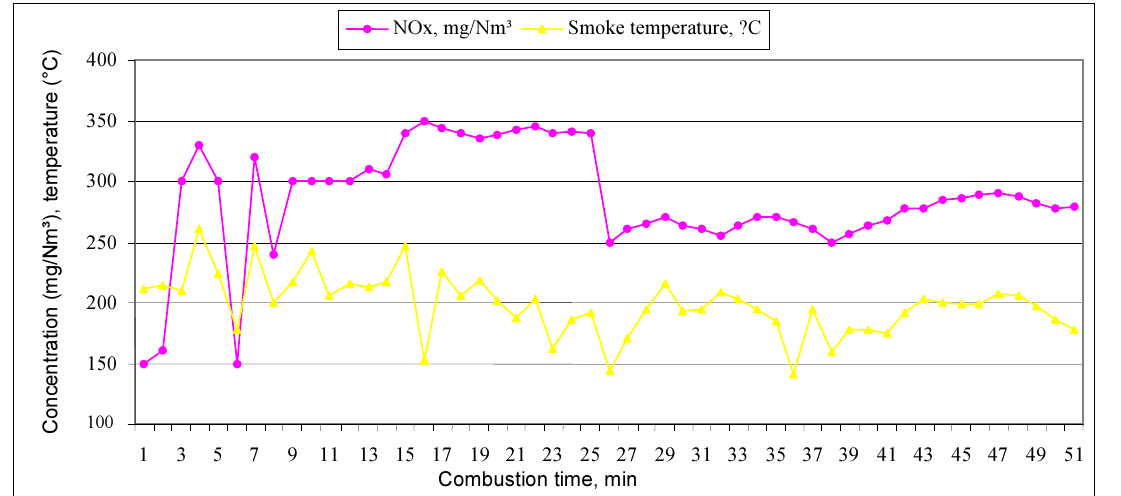
Fig. 3. Change of composition and temperature of smoke burning